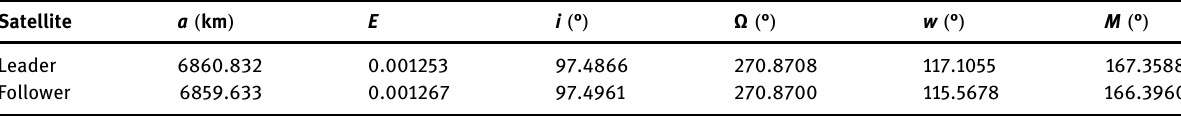
Table 1: Initial orbits of the two satellites ( instantaneous )